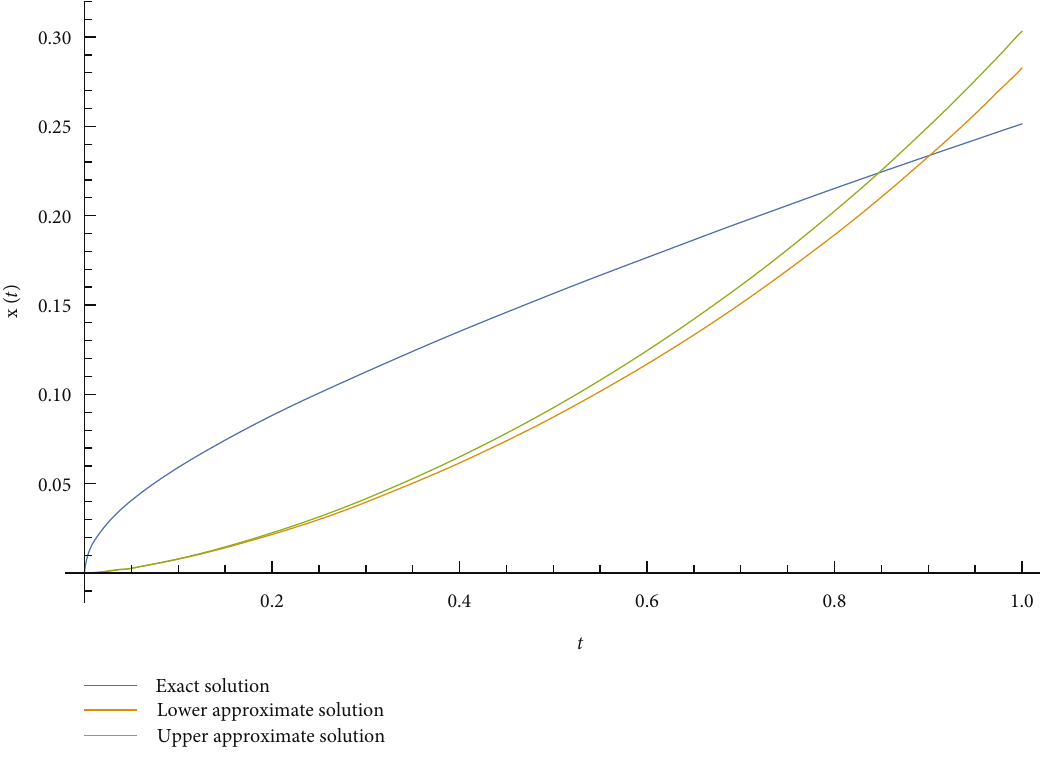
Figure 2: Exact solution with approximate solution F 2